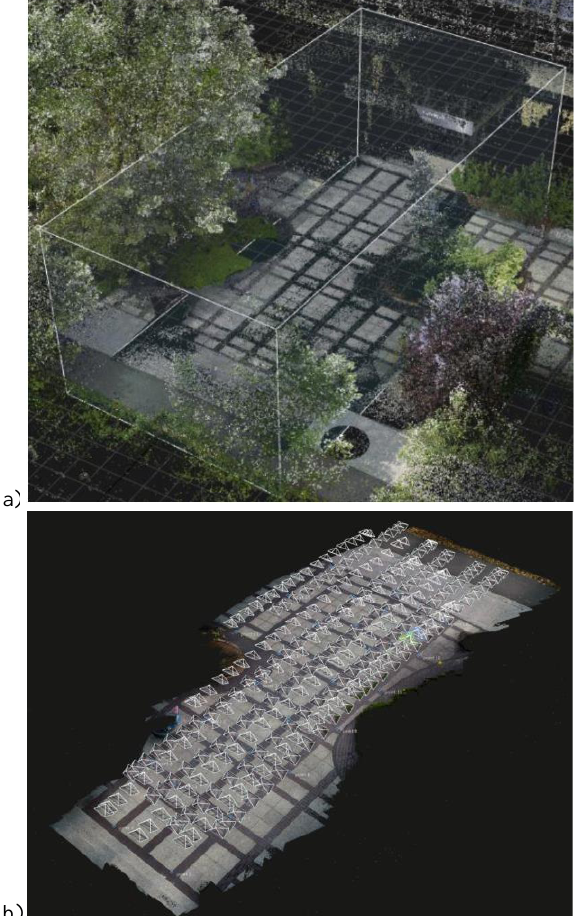
Figure 8. Merged TLS and dense point cloud generated from images acquired with Sony A7R III camera for test area (a), a dense point cloud generated from images acquired with Sony A7R III camera (b) The dense point cloud from TLS was compared with the merged point cloud from TLS and acquired images. A TLS point cloud was treated as a reference. The point clouds were compared excluding trees, including only the pavement in front of the building. In Figure 9, Z-coordinate differences between points clouds: only from TLS and merged TLS and image point cloud.